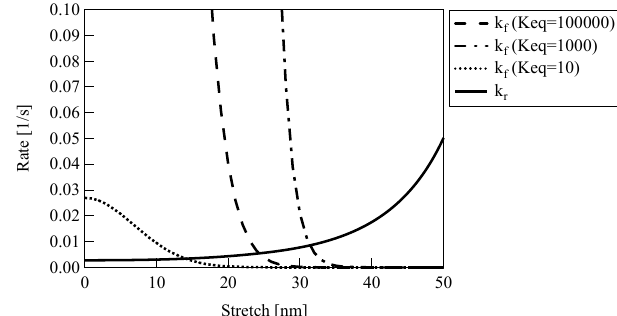
Fig. 8 Transition rates of GPIb α –vWF bond formation ( k